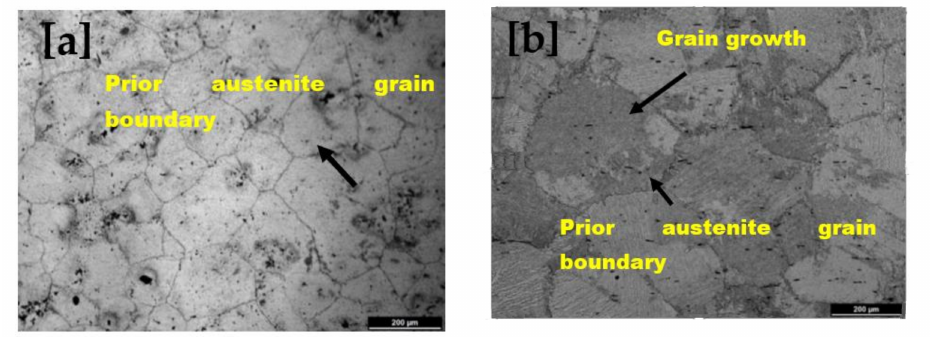
Figure 4. Optical micrographs showing prior austenite grains (PAG) of niobium microalloyed steel in which ( a ) heated at 1250 ◦ C for 10 min, cooled in the air till 950 ◦ C by holding for 10 min and then quenched at ambient temperature; ( b ) heated at 1250 ◦ C for 10 min, cooled in the air till 950 ◦ C by holding for 30 min and then quenched at ambient temperature.